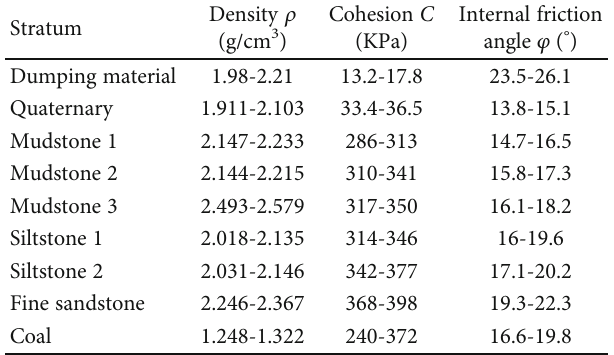
Figure 8: Variation law of slope stability in the process of land saving and loss